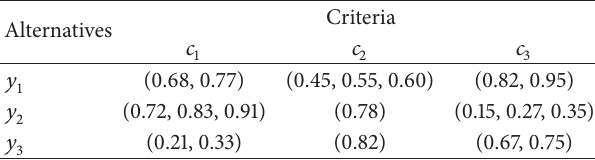
Table 1: The hesitant fuzzy multicriteria aggregation matrix.